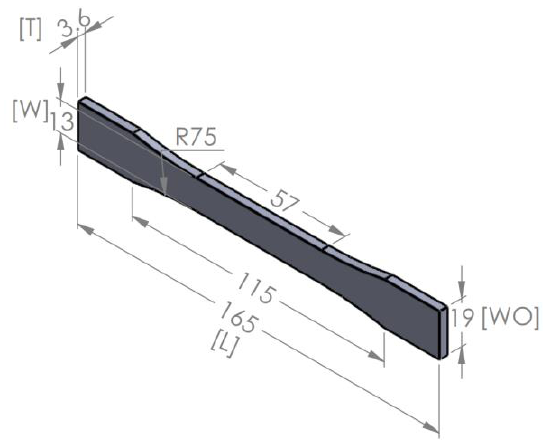
Figure 1. Standard test specimen in mm.